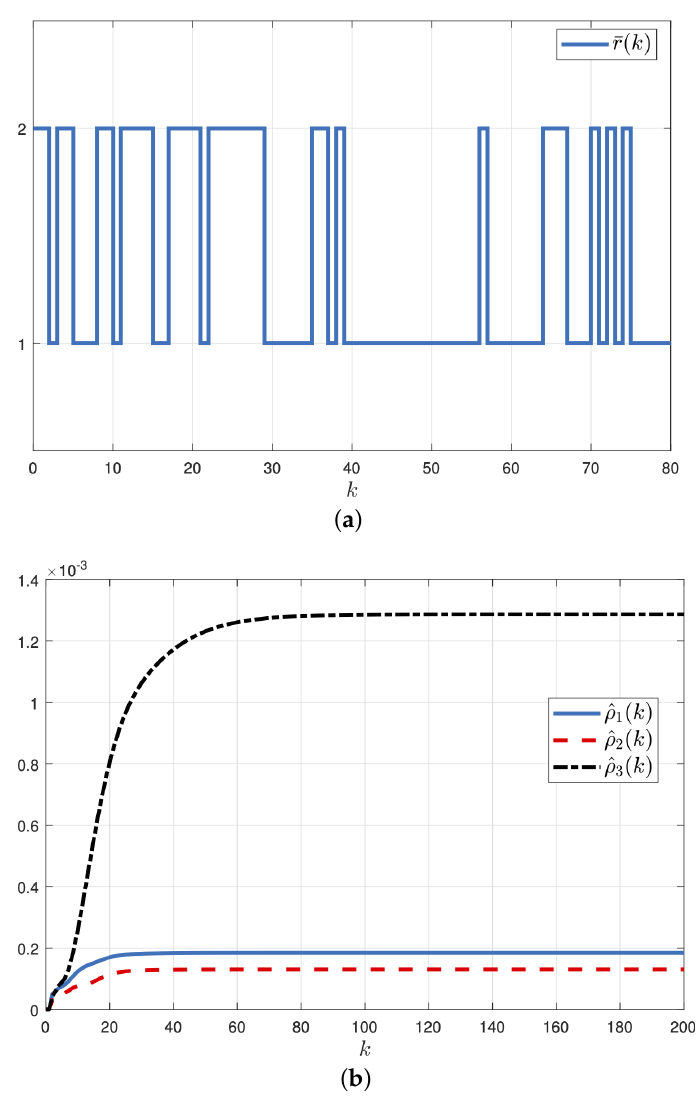
Figure 4. A possible sequence of the system mode ( a ) and trajectory of the adaptive variables ( b